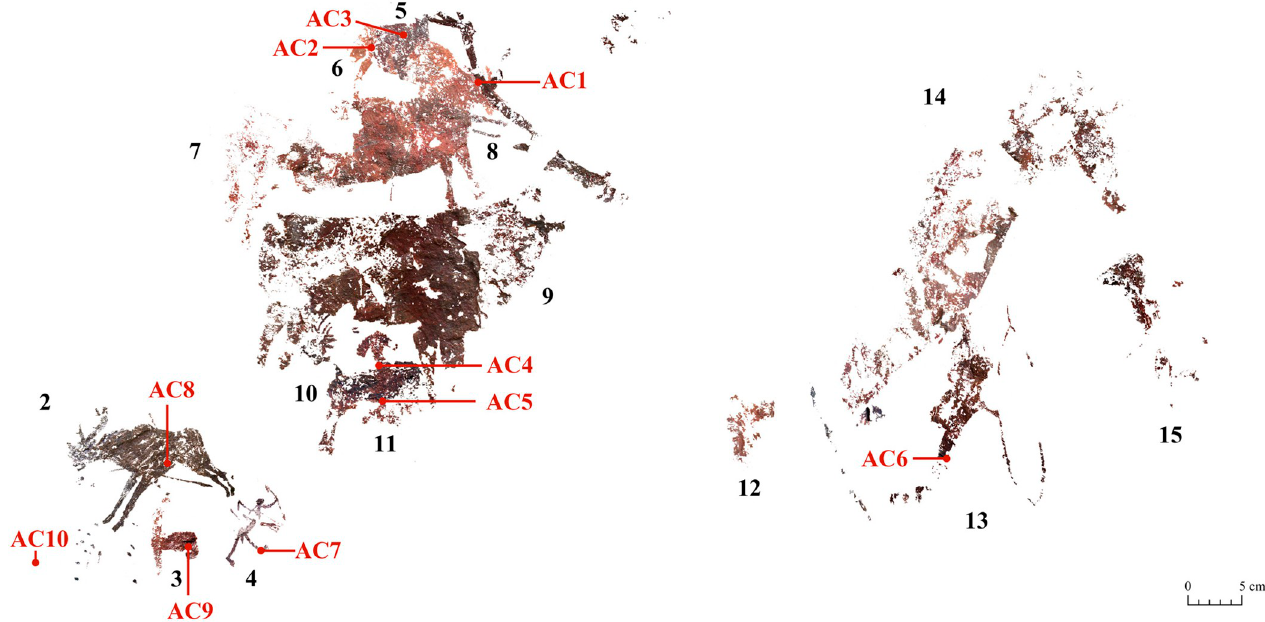
Fig 2. Digital tracing of the Levantine and Schematic paintings of el Carche rock shelter. Black numbers refer to motifs: 2. Deer, 3. Schematic unidentified quadruped, 4. Linear archer, 5. Human legs, 6. Unidentified quadruped, 7. Horse, 8. Potential remains of an animal, 9. Deer, 10. Deer, 11. Schematic anthropomorphic figure, 12. Archer, 13. Archer, 14 and 15. Unidentified quadruped. Red numbers refer to the points where microsamples were collected that are highlighted with a line. See Table 1 for further information on the